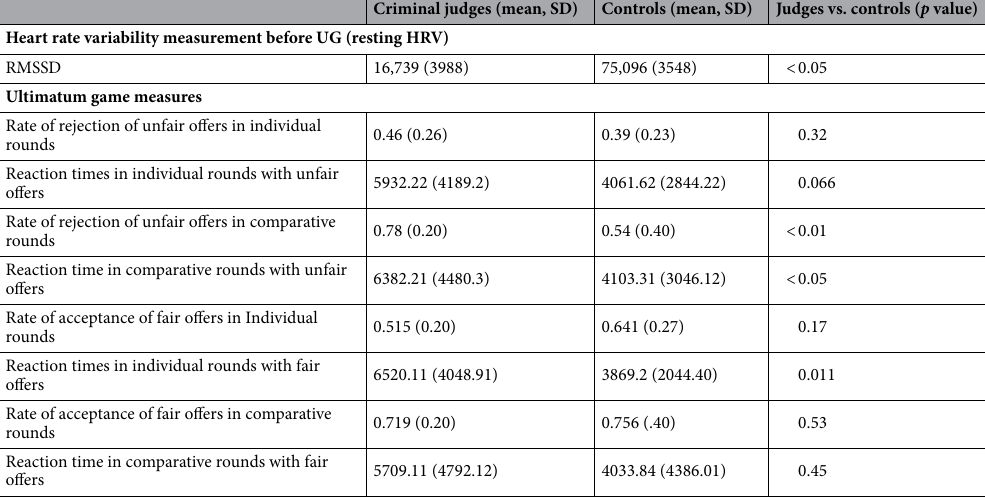
Table 2. Comparisons between groups in UG rounds and in HRV